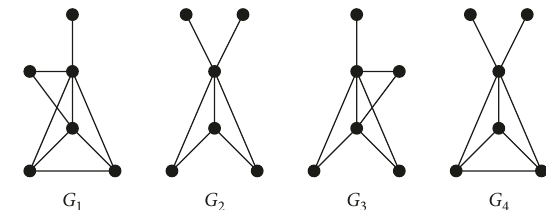
Figure 1: Four 6-vertex nonregular graphs selected for